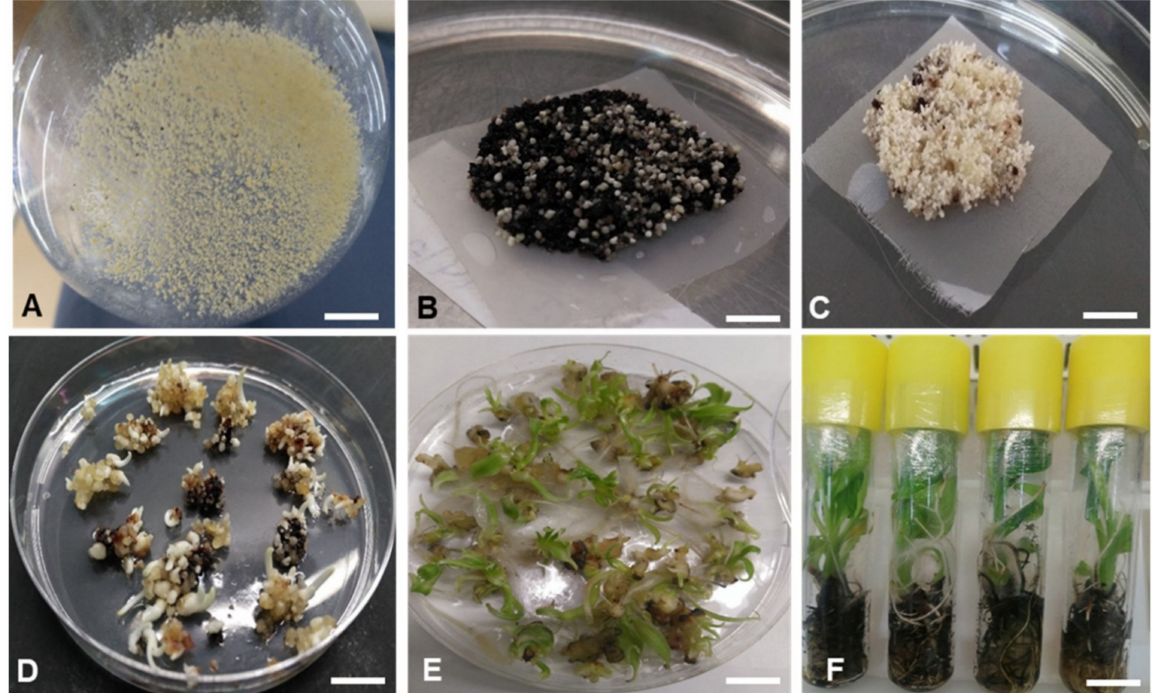
Figure 3. Transformation, selection, and regeneration of putative transgenic events. ( A ) Proliferating embryogenic cell suspension, ( B ) developing embryos on transformed embryogenic cells on selection medium, ( C ) developing embryos on control untransformed embryogenic cells on nonselective medium, ( D , E ) germinating embryos, ( F ) fully regenerated putative transgenic plant. Scale bar = 1